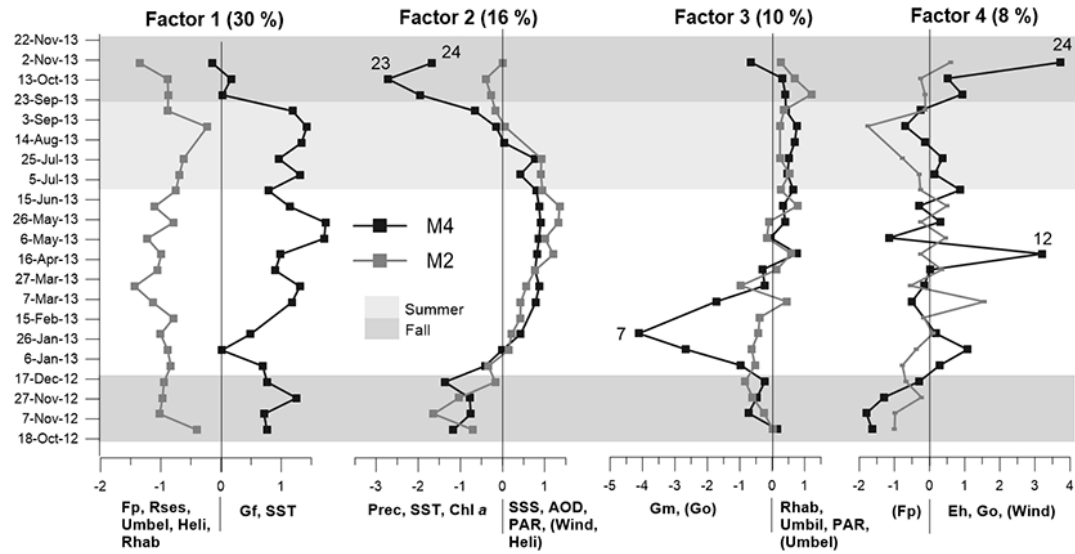
Figure 7. Spatio-temporal variation in the scores obtained from factor analysis. For taxonomical references, see Table